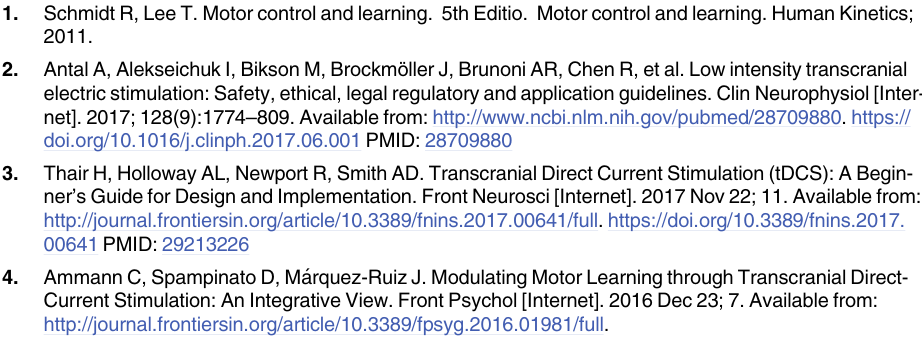
S3 Table. Self-reported measures of affect. The Positive and Negative Affect Schedule (PANAS) to screen for mood was administered before (Pre) and after (Post) the session on Day 1 for both anodal and sham transcranial direct current stimulation (tDCS) groups. Data represent mean (SD). A higher “positive” score indicates a more positive affect; a lower “nega- tive” score indicates less of a negative affect. Scores range from